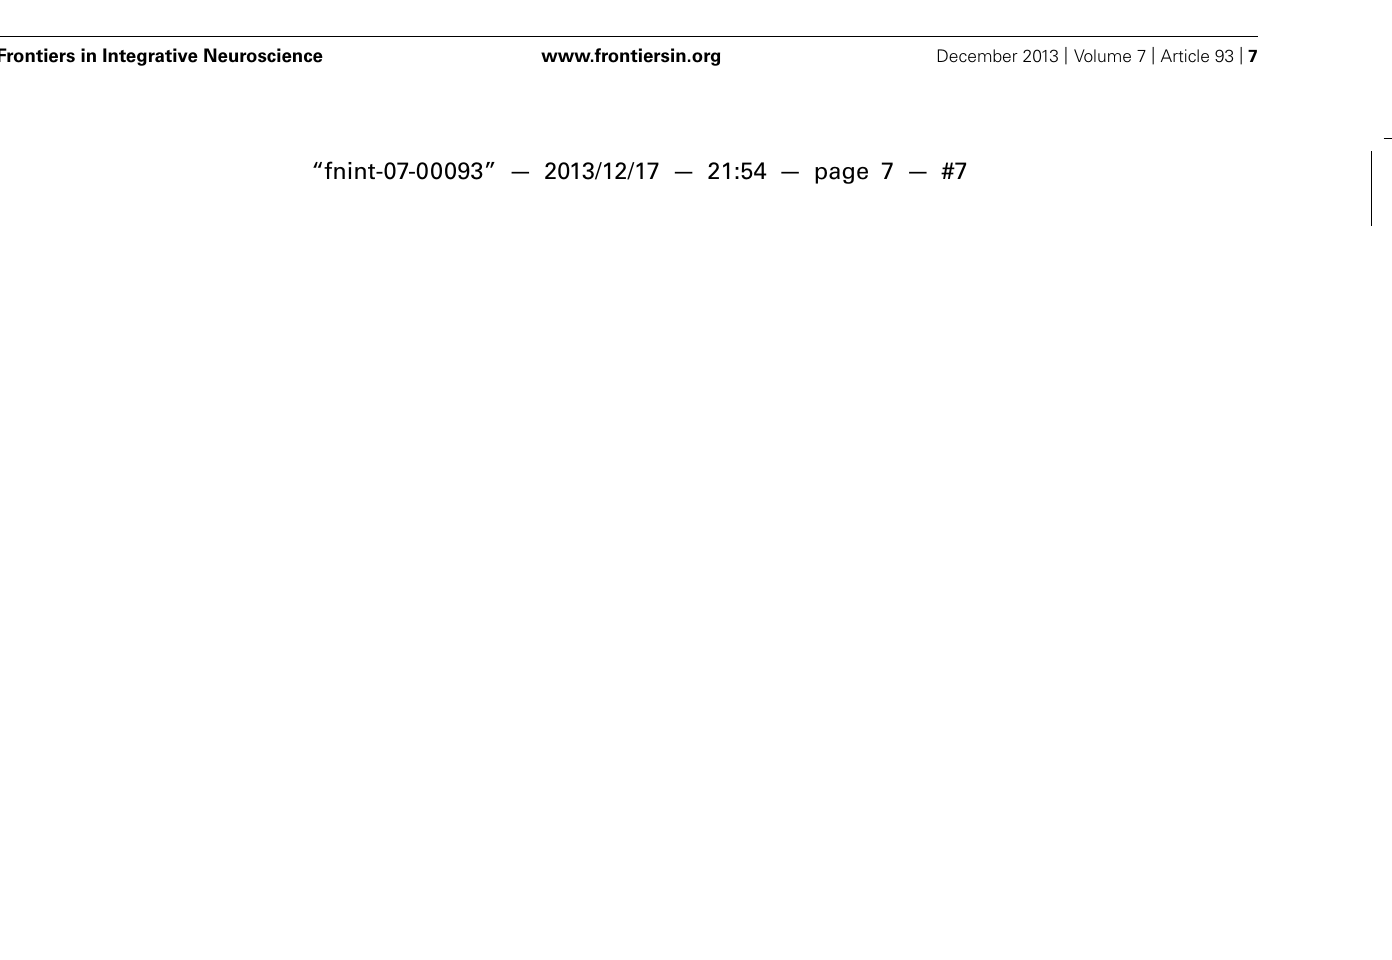
data for DSI induced by depolarizing pulses with a duration of 0.5, 1, 3, and 5 s are plotted. (C) No correlation was found between DSI magnitude and size of GABA A IPSC in either sex. (D) Bar graphs summarizing the average paired-pulse ratio (IPSC2/IPSC1) of rostral GABA A IPSCs for all cells recorded in male and female LH rats. No sex dimorphism was found in DSI-induced increased paired-pulsed ratio. (E) In the presence of either CB1 receptor antagonist (AM281) or inhibitor of sn -1-DAGL (THL) DSI could not be induced in either sex. Data are expressed as mean ± SEM. * P < 0.05, ** P < 0.01, and *** P <